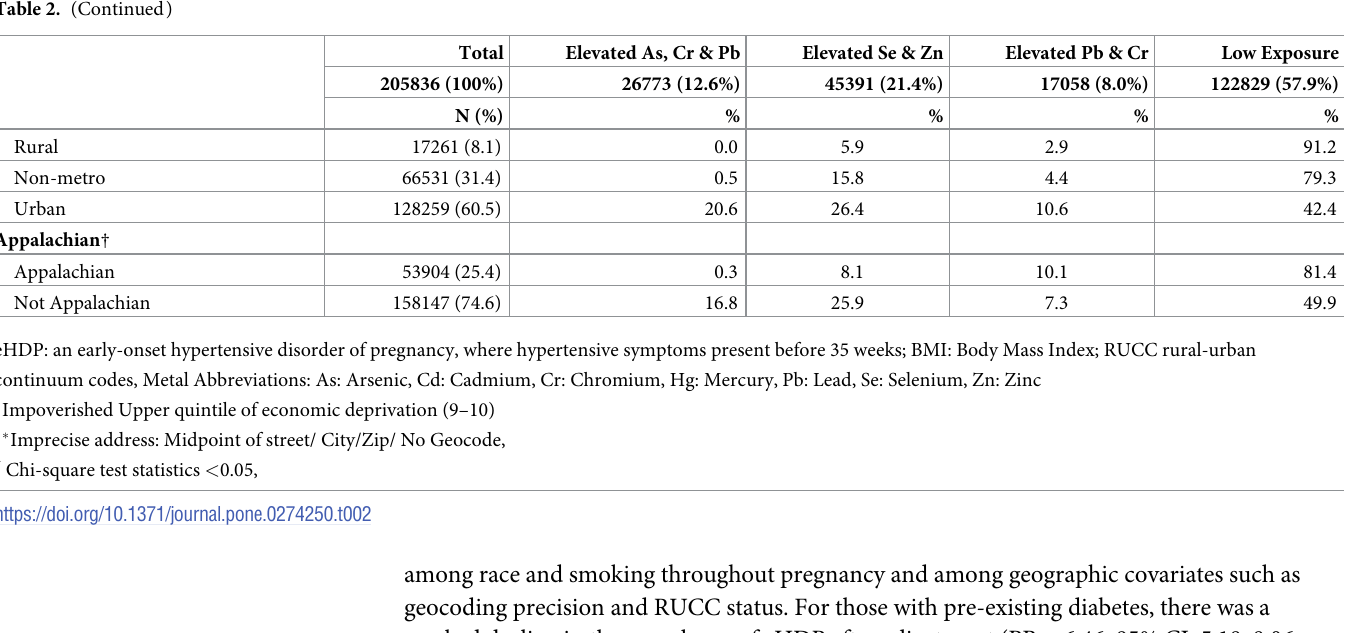
geocoding precision and RUCC status. For those with pre-existing diabetes, there was a marked decline in the prevalence of eHDP after adjustment (PR = 6.46, 95% CI: 5.18, 8.06 vs. aPR = 4.20, 95% CI: 3.34,